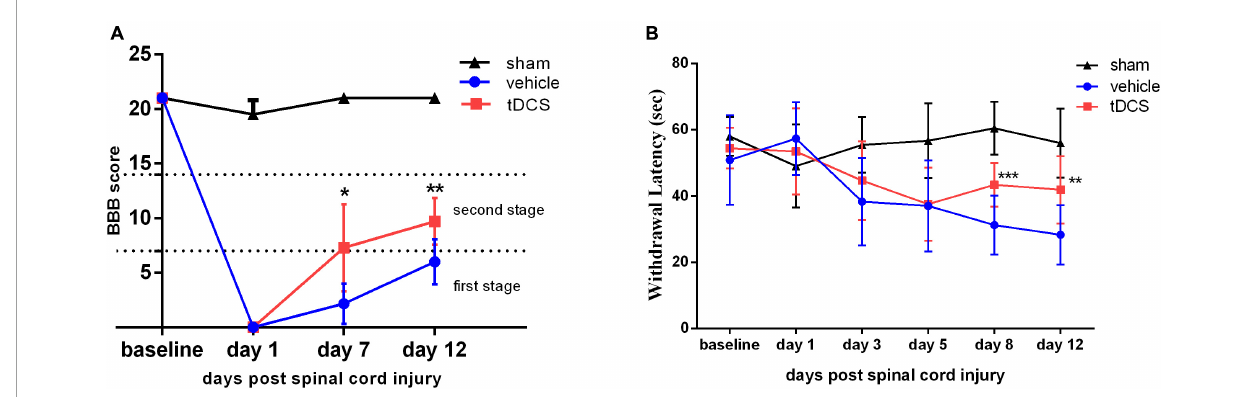
FIGURE2 tDCS promotes the recovery of behavioral tests after SCI. Statistical analysis of (A) the Basso-Beattie-Bresnahan (BBB) score and (B) the Withdrawal latency for the sham, vehicle, and tDCS groups. tDCS group vs. Vehicle group, *** p < 0.001, ** p < 0.01, * p < 0.05, n ≥ 7.